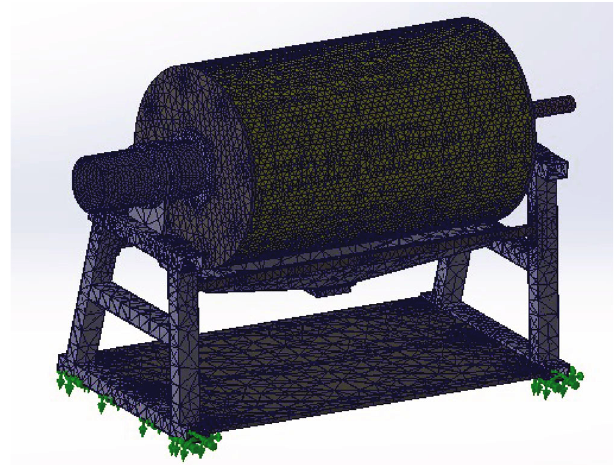
Figure 16: Finite Element Analysis model showing the mesh and supports.